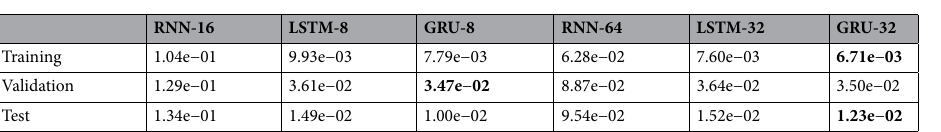
Table 1. The average RMSE out of ten simulations, for RNN with 16 and 64 hidden units and for LSTM and GRU with 8 and 32 hidden units, for the iteration with the smallest validation loss. Significant values are given in bold.